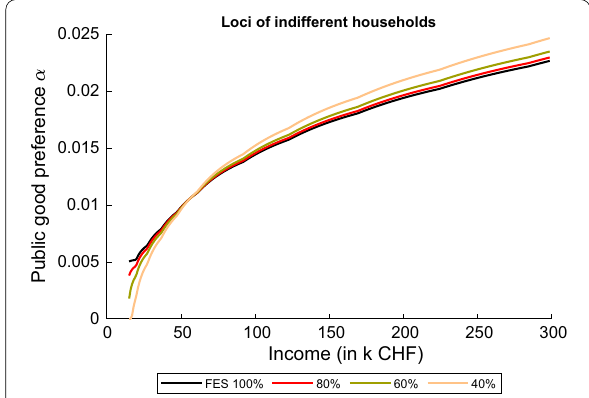
Fig. 3 Phasing-out the FES: effects on the distribution of households in the y - α